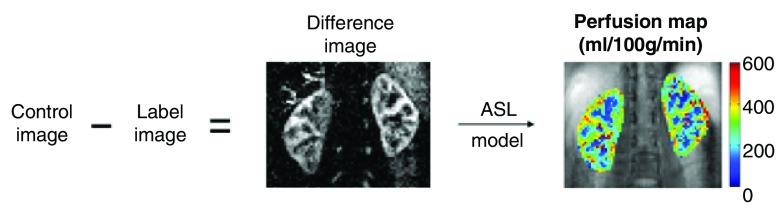
Overview of arterial spin labeling (ASL).A control image is obtained without contrast. A pulse is then used to magnetize the blood, and a delay allows the blood to enter the kidney. The labeled image is then subtracted from the baseline image, generating a map of the signal difference created by the perfused blood. In healthy volunteers, the amount of signal due to inflowing blood is in the order of 5% of the non-background suppressed baseline tissue magnetization. Reproduced with permission from Nery, Gordon, and Thomas
16.